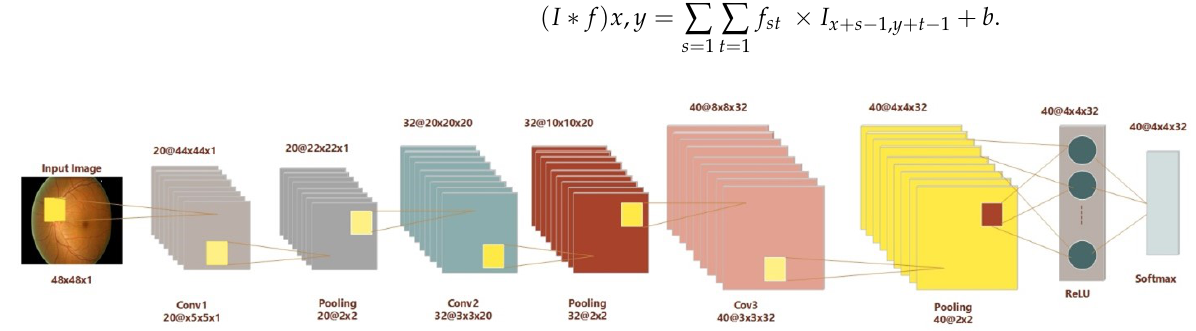
Figure 2. Deep CNN Architecture for the Input